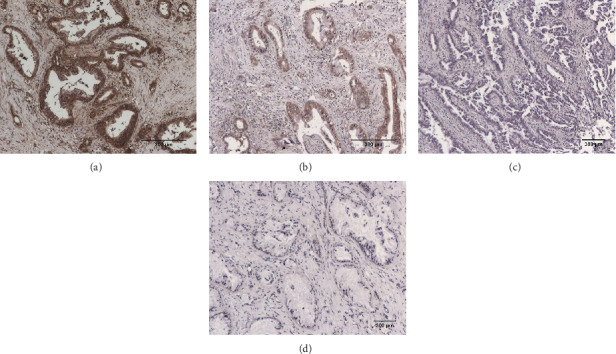
14-3-3δ is overexpressed in extrahepatic CCA patients' tumor tissues. Representative immunohistochemistry images of positive A (++), B (+), and negative C (-), D (-) 14-3-3δ in extrahepatic cholangiocarcinoma specimens.